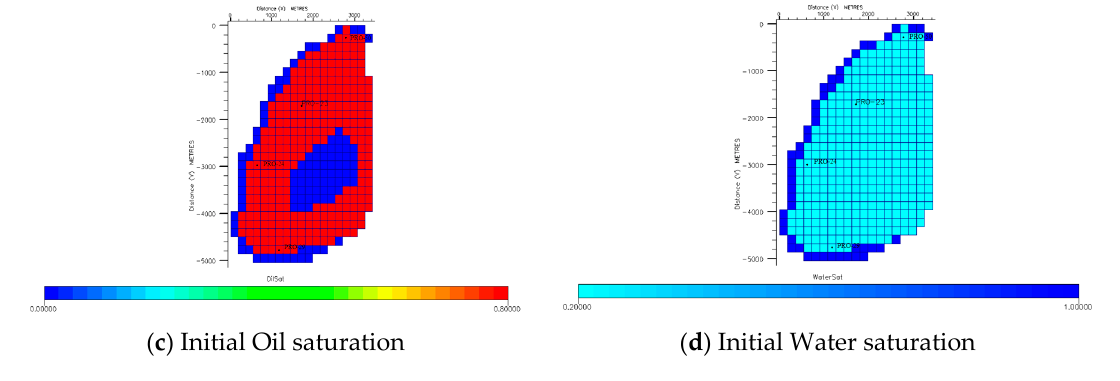
Figure 4. Description for case study 1.